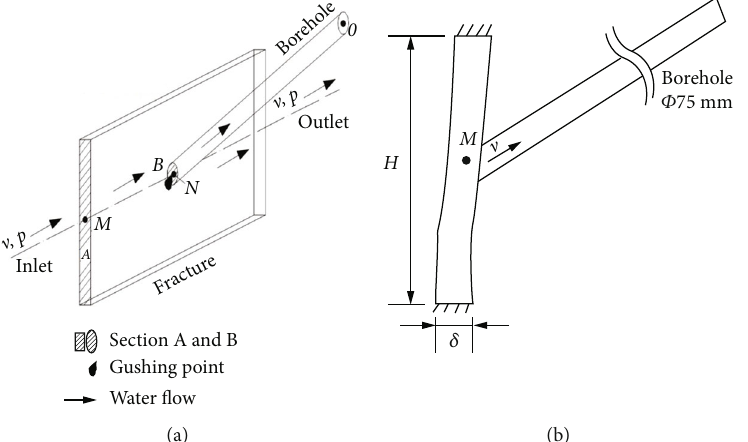
Figure 4: (a) Schematic of free fl ow for fracture-borehole fl ow system and (b) cross section. v is fl uid velocity, and p is water pressure. H is the height of aquifer, and δ is the fracture aperture.